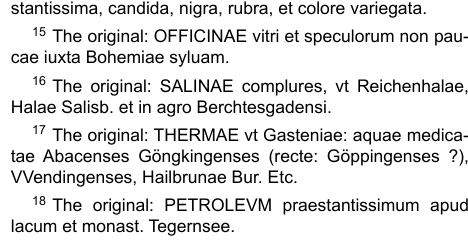
lacum et monast. Tegernsee.